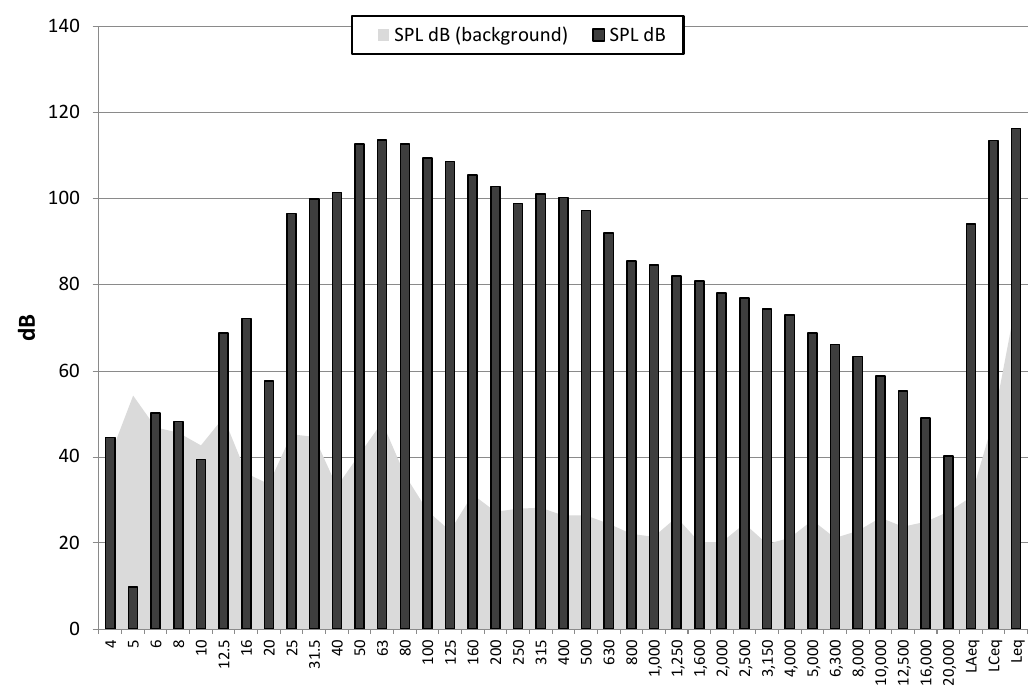
Figure 24. Waveforms of Sound Pressure Level: SPL A-weighting, SPL C-weighting, SPL (unweighted)—1000 g buried explosive charge-Station 3.